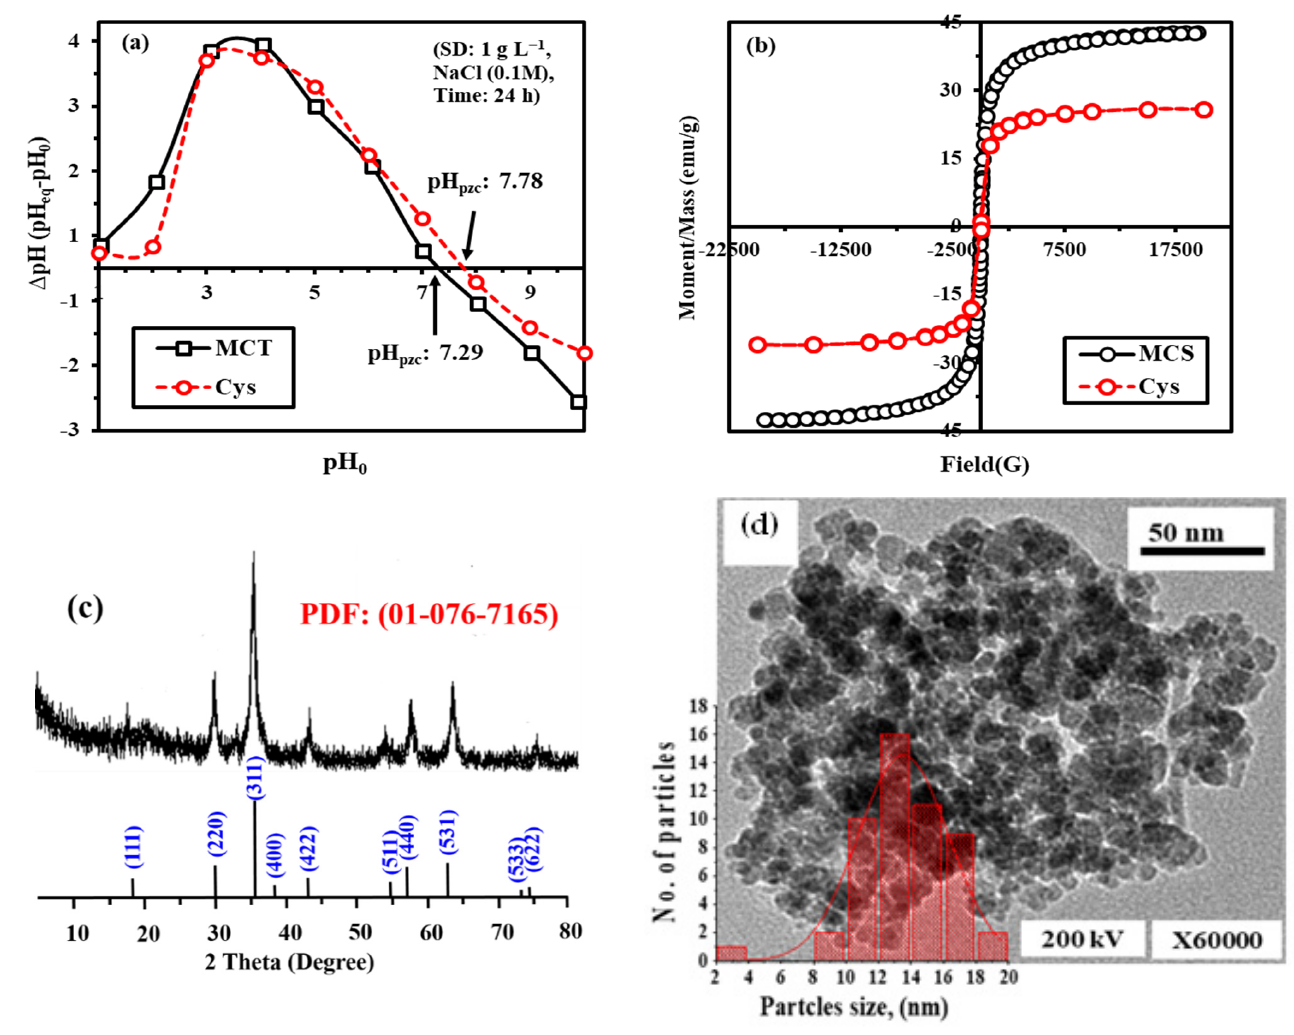
Figure 1. ( a ) Determination of pH PZC by the pH-drift method; ( b ) Magnetization curves of MCT and Cys; ( c ) XRD patterns of Cys (the bar-type spectrum represents the XRD referenced pattern of magnetite); and ( d ) TEM micrographs (the bar is 50 nm).